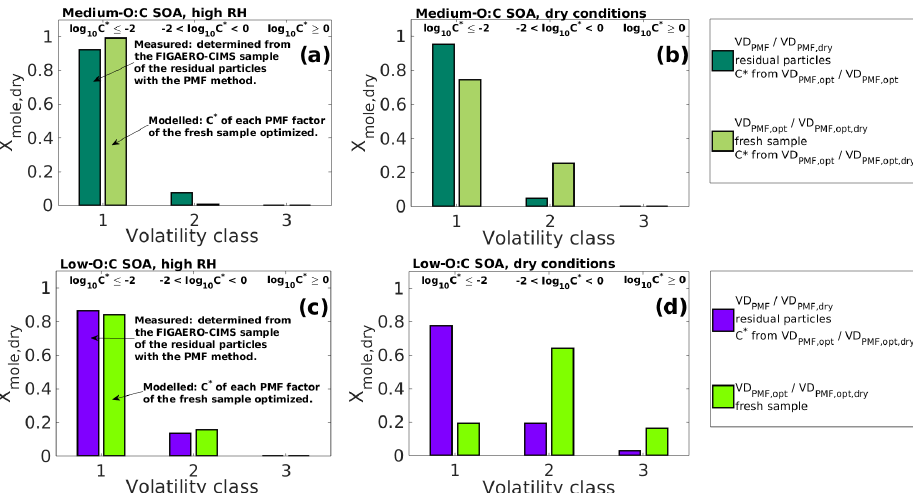
Figure 6. Comparison of the simulated particle composition (VD PMF , opt ; VD PMF , opt , dry ) to the particle composition determined from the residual particles collected from the RTC (VD PMF /VD PMF , dry ) after 173–259 and 168–254min of evaporation for medium- and low-O : C SOAs, respectively. The comparison is done at the mean evaporation time of the residual particles. The simulated compositions (VD PMF , opt – a and c ; VD PMF , opt , dry – b and d ) are taken from the best-fit simulated evapogram obtained from the optimization of the C ∗ values of the fresh sample’s PMF factors to the measured evapogram. The volatility of the individual volatility distribution (VD) bins are grouped into three volatility classes, similar to Fig. 3. The limits for each volatility class are shown at the top and are the same for each subfigure. The C ∗ values from VD PMF , opt /VD PMF , opt , dry were used for corresponding VD PMF /VD PMF , dry when the volatility grouping was calculated in order to ensure the comparability. (a) Medium-O : C SOA in the high-RH experiment. (b) Medium-O : C SOA in the dry-condition experiment. (c) Low-O : C SOA in the high-RH experiment. (d) Low-O : C SOA in the dry-condition experiment. In the high-RH cases ( a ) and ( c ), the volatility distributions simulated, based on VD PMF , opt of the fresh SOAs, are similar to the measured VD PMF , while for the dry-condition cases ( b ) and ( d ), the volatility distributions simulated, based on VD PMF , opt , dry , show higher volatility than the measured VD PMF